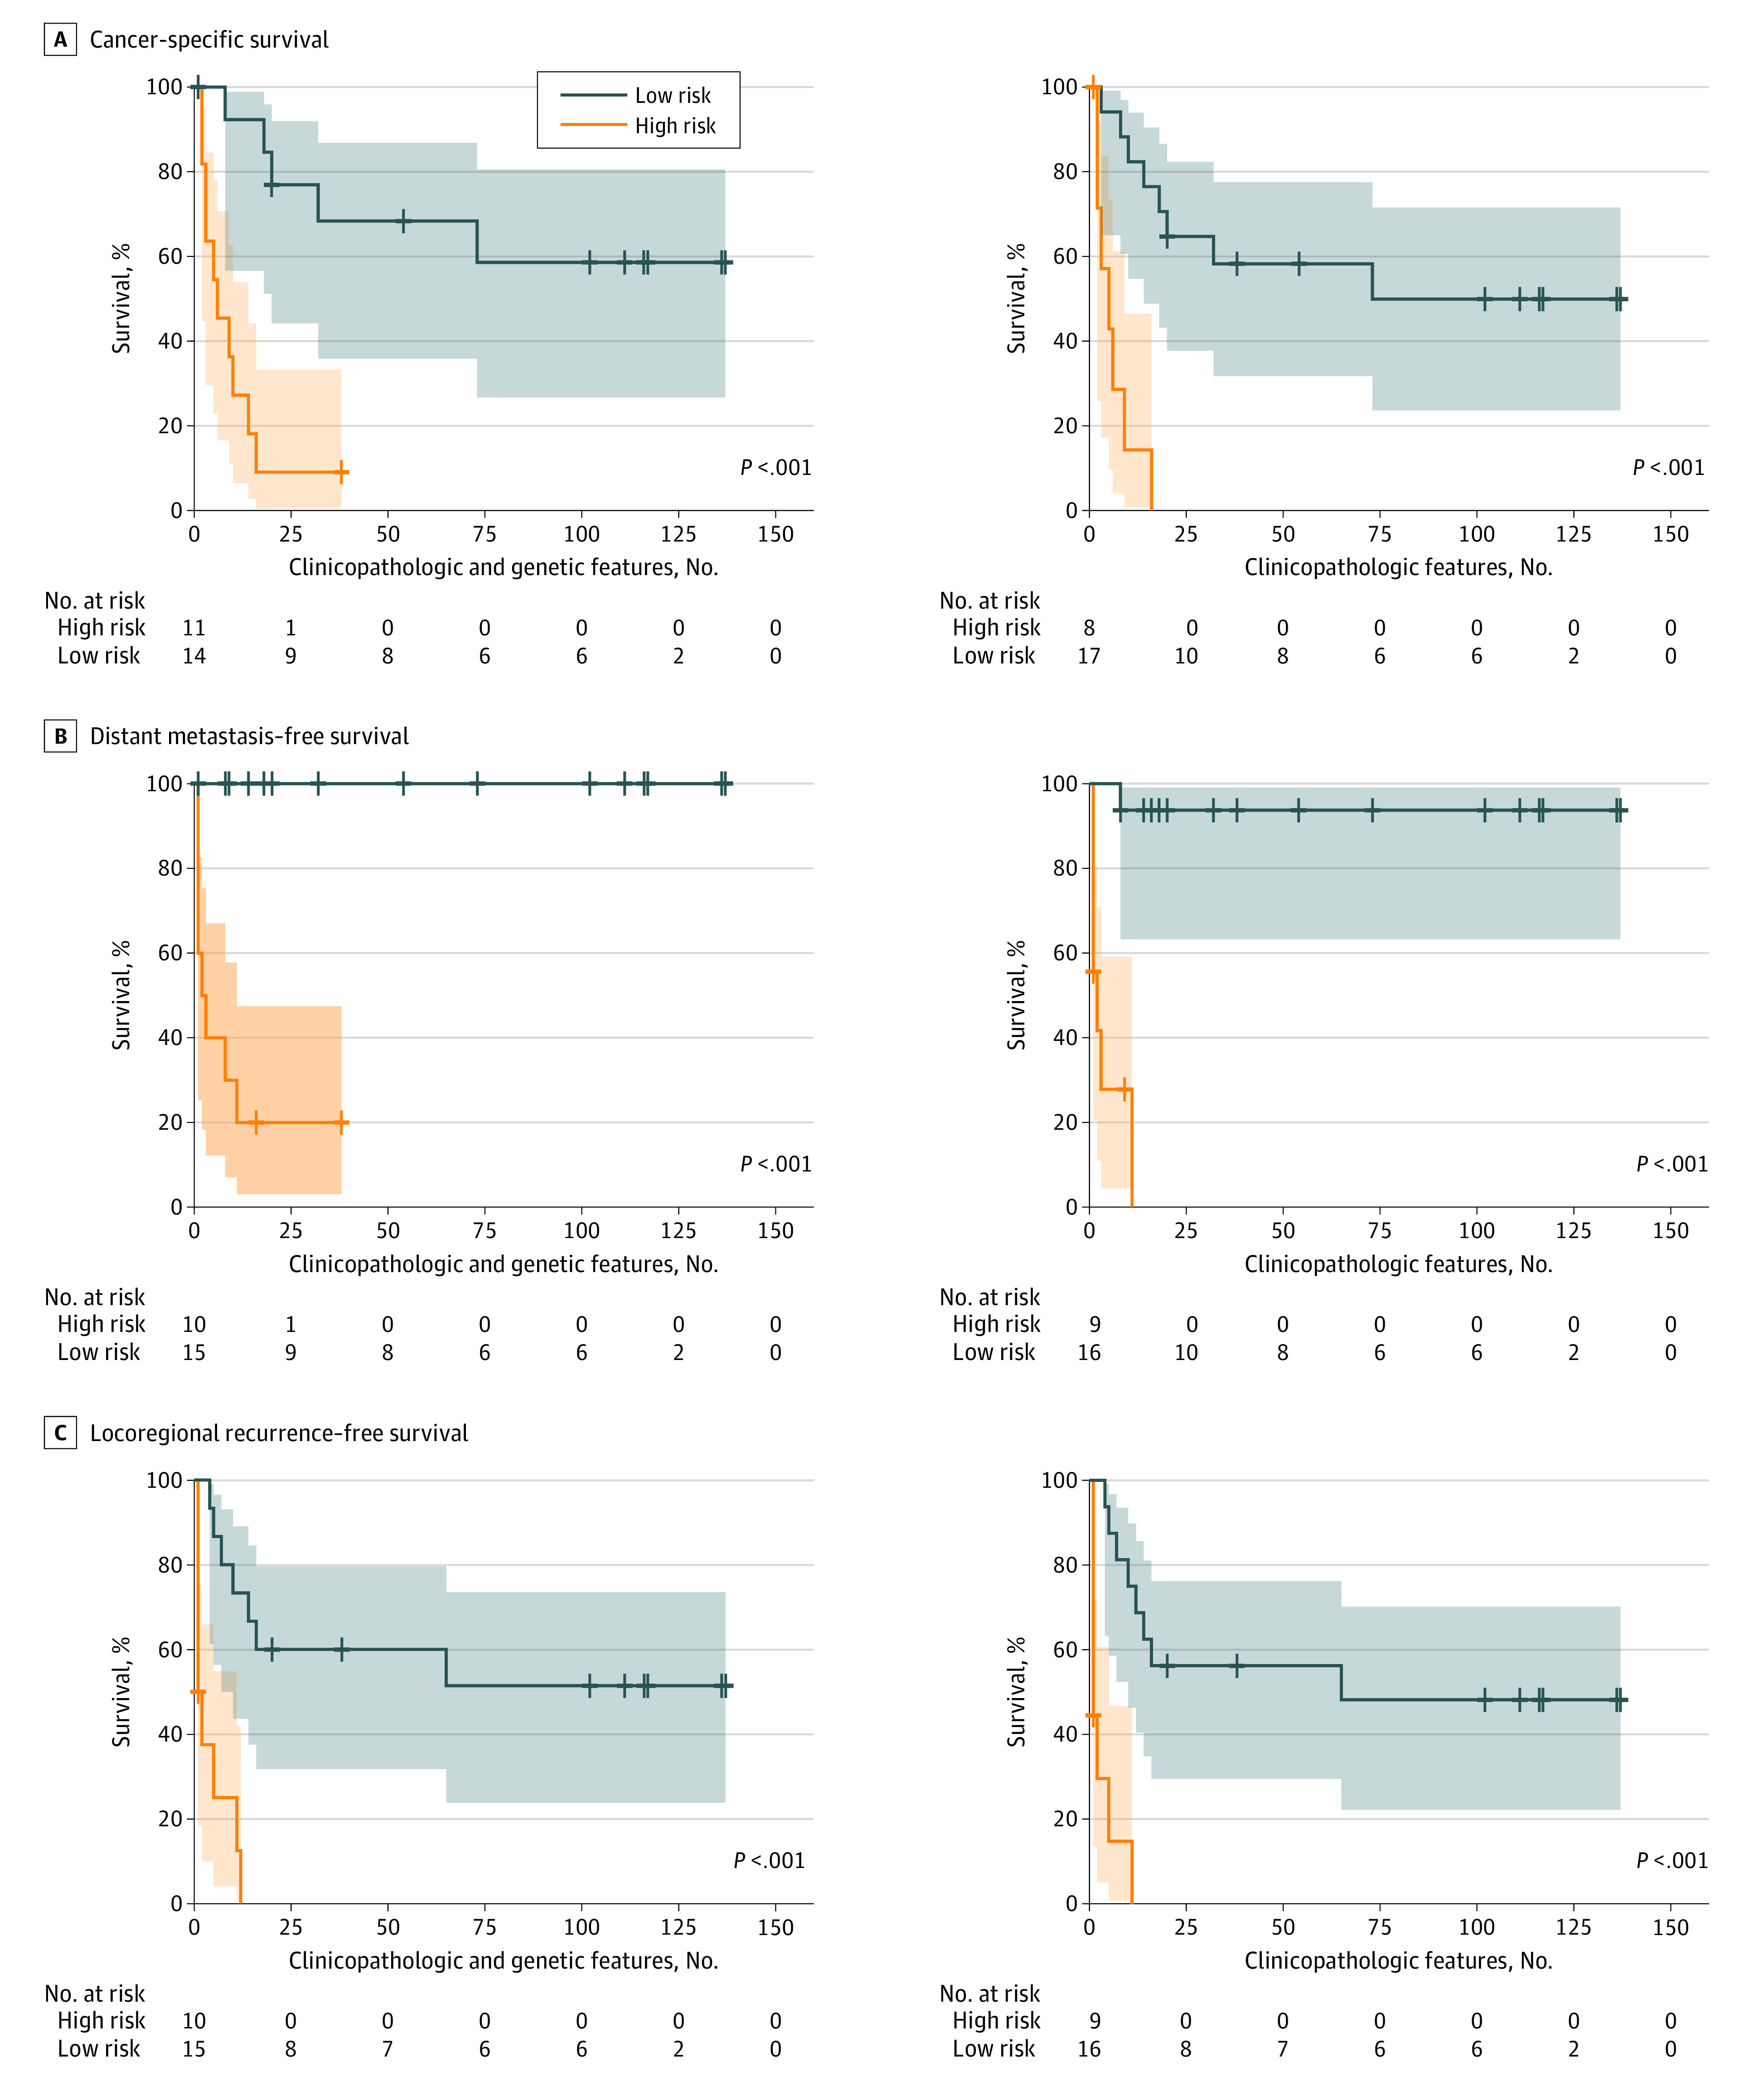
Kaplan-Meier Curves of Patients Who Underwent Surgery Alone Stratified Using Elastic Net Penalized Cox Proportional Hazards Regresssion Models Built With Clinicopathologic and Genetic Features vs Clinicopathologic Features AloneA, Cancer-specific survival. B, Distant metastasis–free survival. C, Locoregional recurrence–free survival. The shaded areas indicate 95% CIs.